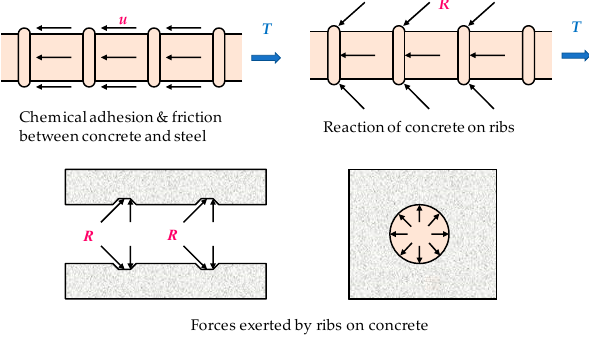
Figure 1. Bond force transfer mechanisms.